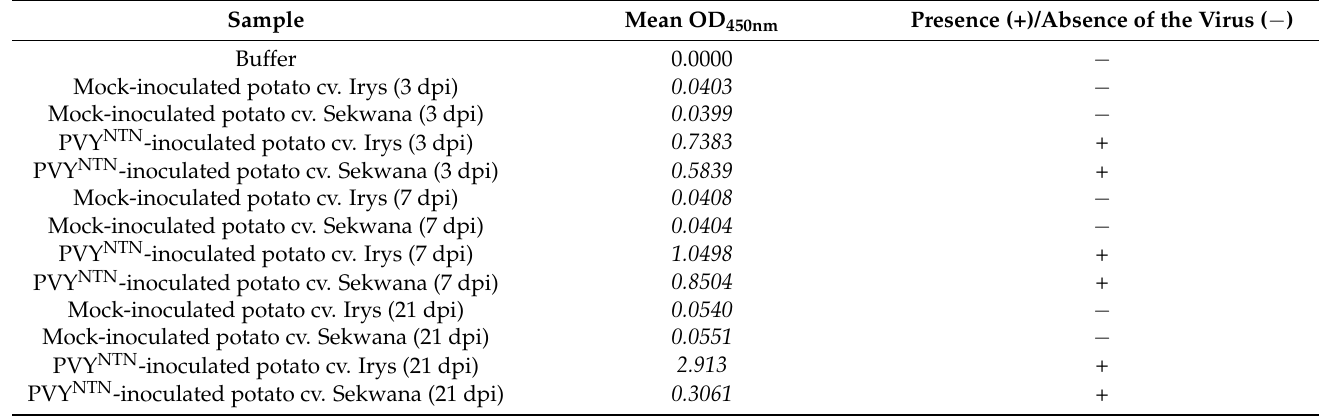
Table 4. PVY NTN detection using DAS-ELISA assay in mock- and virus-inoculated potato plants as reflected by mean OD 405nm values. The absence of a virus is marked by ( − ). The presence of PVY NTN ( + ) is considered positive when the mean OD 405nm values reach the cut-off point